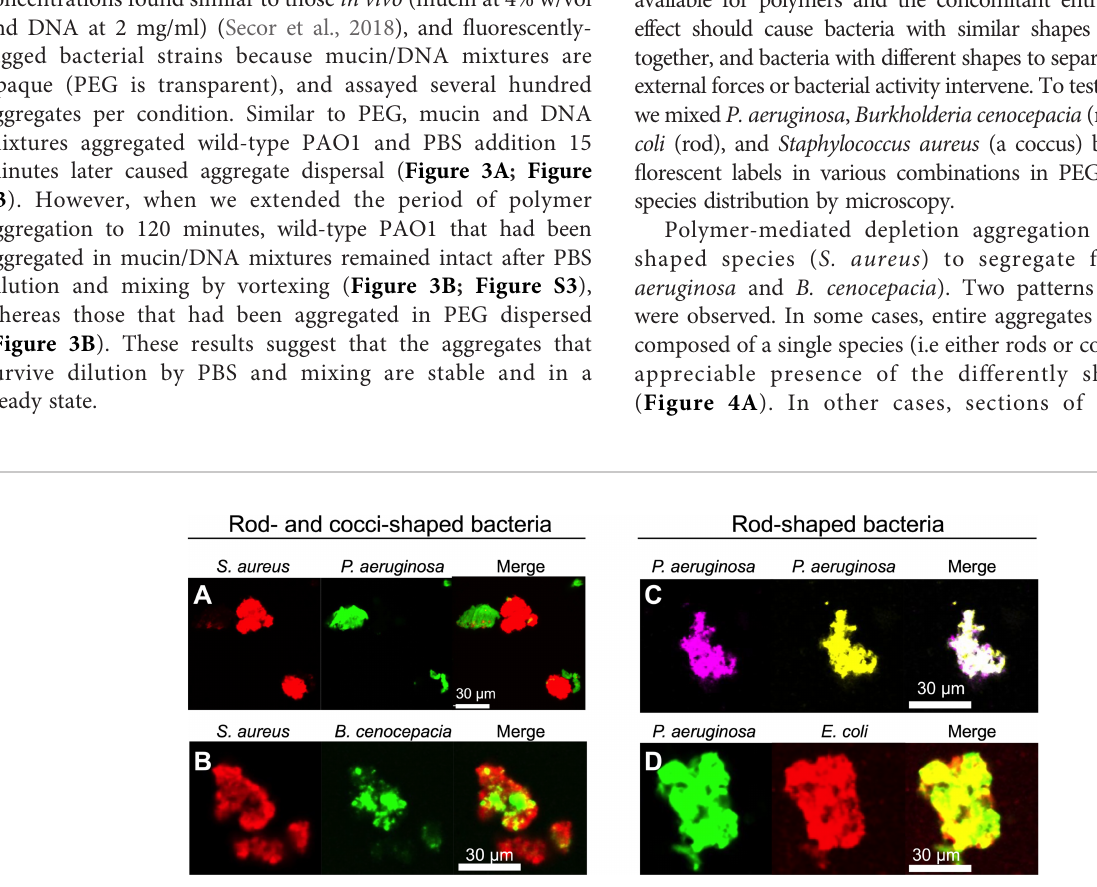
FIGURE 4 | Depletion aggregation spontaneously segregates bacteria with different cell shapes. Equal numbers of the indicated species (10 9 CFU/ml each) were mixed prior to the addition of PEG 35 kDa to induce depletion aggregation. After 18 hours, aggregates were imaged by fl uorescent microscopy. Representative images of depletion aggregates composed of (A) P. aeruginosa expressing GFP and S. aureus expressing mCherry, (B) S. aureus expressing mCherry and B. cenocepacia expressing GFP, (C) P. aeruginosa expressing either YFP or CFP, or (D) P. aeruginosa expressing GFP and E. coli expressing mCherry are